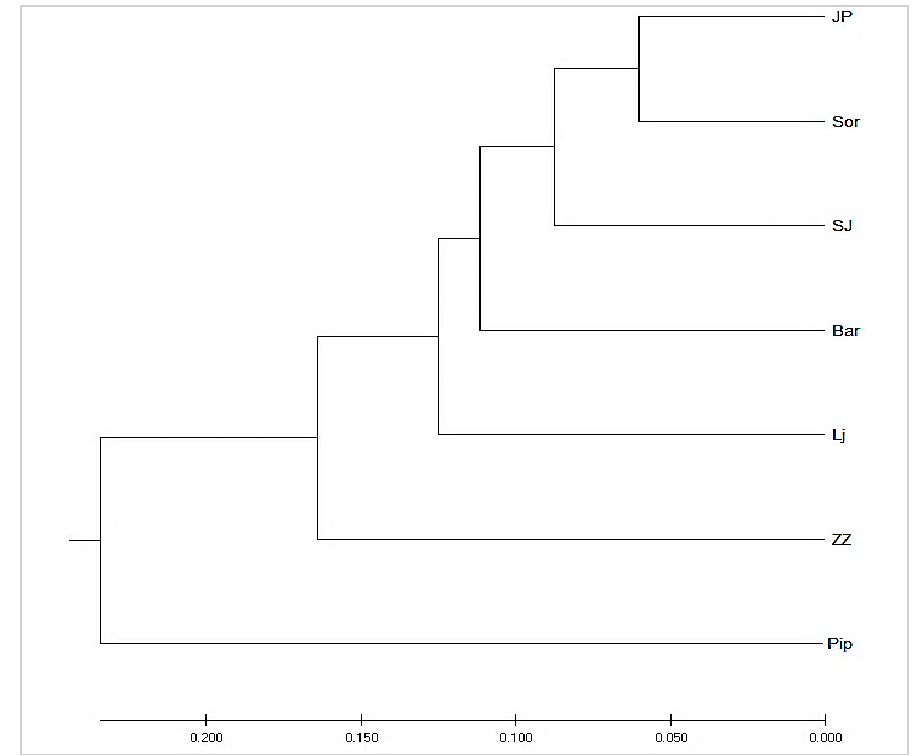
Figure 4. UPGMA dendrogram of seven populations of Montenegrin sheep constructed from Nei’s standard genetic distance (Abbreviations the same as those in Table 5).